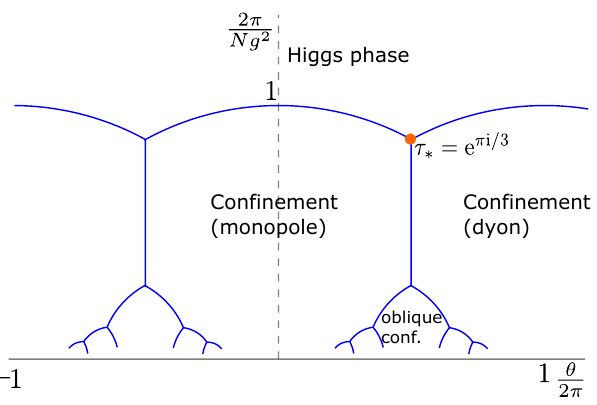
Figure 1 . Conjectured phase diagram of the Cardy-Rabinovici model. In the weak-coupling regime, electric charge condensation occurs and the system is in the Higgs phase. In the strong-coupling regime, magnetic charge condensation occurs. Depending on the values of θ , different types of dyon start to condense, and the Cardy-Rabinovici model is expected to have the rich phase